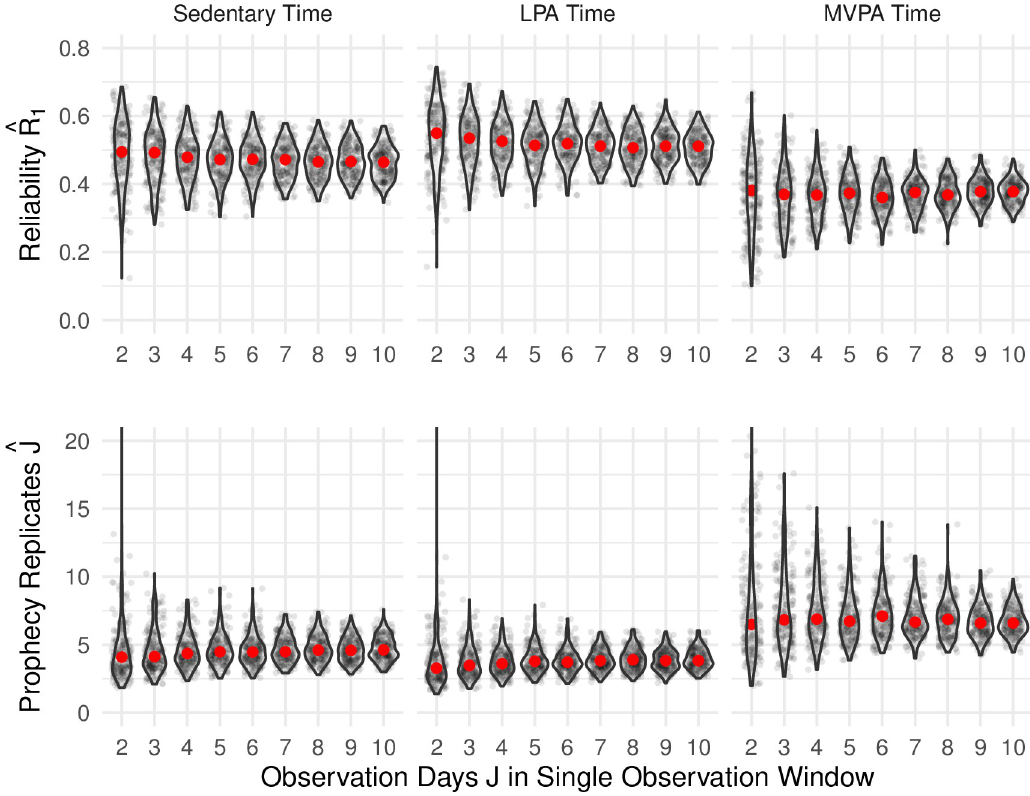
Fig 3. Estimated reliability and number of days. The top row shows the empirical distribution of estimated reliability ^ R ^ sedentary, LPA, and MVPA time. Each panel shows the distribution of reliability estimates ^ R ^ between 2 and 10 days with individual points showing the results for a single generated dataset. The bottom row shows the corresponding empirical distribution of the number of replicates ^ J ^ 0.80 for each activity metric and observation window. Solid red circles indicate the median across 200 sampled datasets.